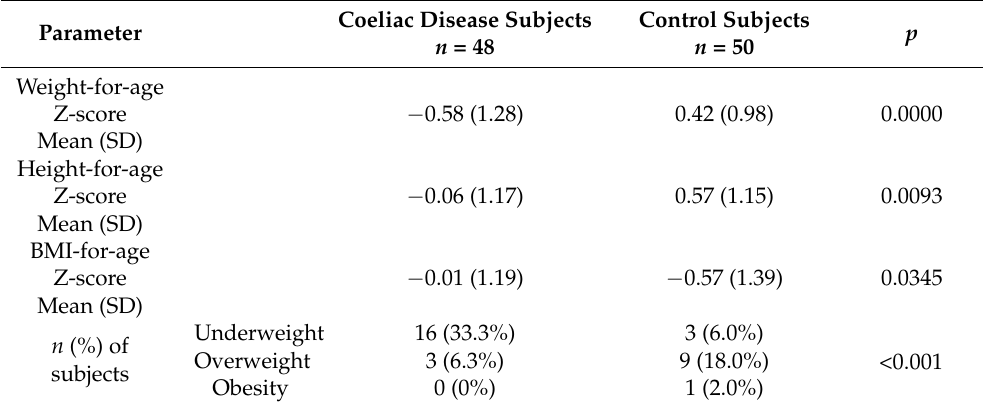
Table 2. Anthropometric parameters of coeliac disease patients and control subjects compared with weight, height and body mass index (BMI) standards for Polish children [15].